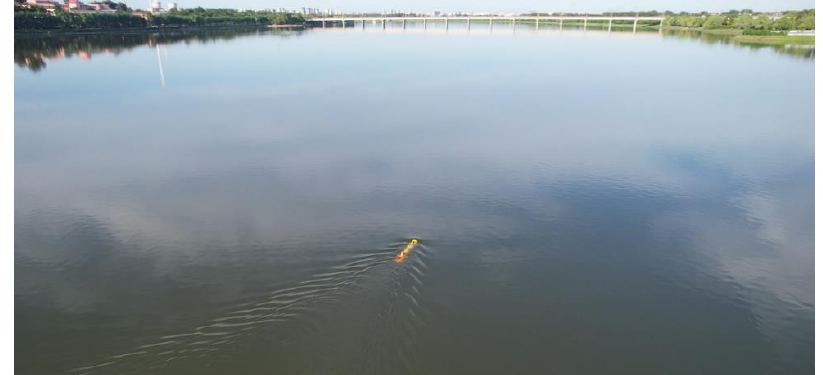
Figure 10. Experimental site.